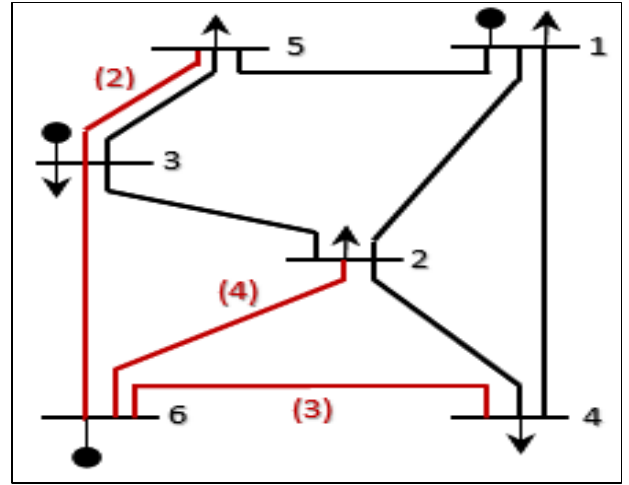
Figure 3: G-6/15 system -Planned network.